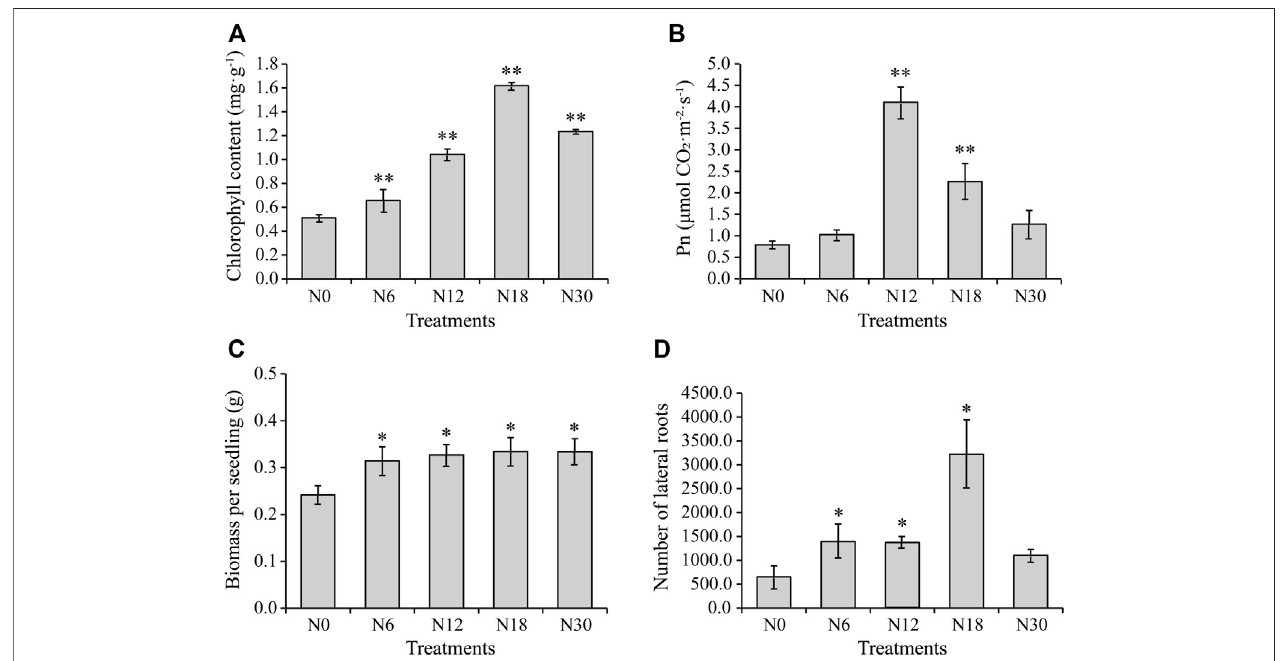
FIGURE 1 | Physiological characteristics of moso bamboo seedlings under different nitrogen additions: (A) chlorophyll content of leaves, (B) Pn of leaves, (C) biomassperseedling,and (D) numberoflateralrootsfromseedlingsunderdifferentnitrogenadditions.Dataaremeans±SDofthreereplicates( n =3).Asterisksindicate thesigni fi cantdifference betweenN0and othernitrogen additions(*means p < 0.05,**means p < 0.01, thesamebelow). RNAsequencingelucidatedtheDEGsinroots under different nitrogen additions.